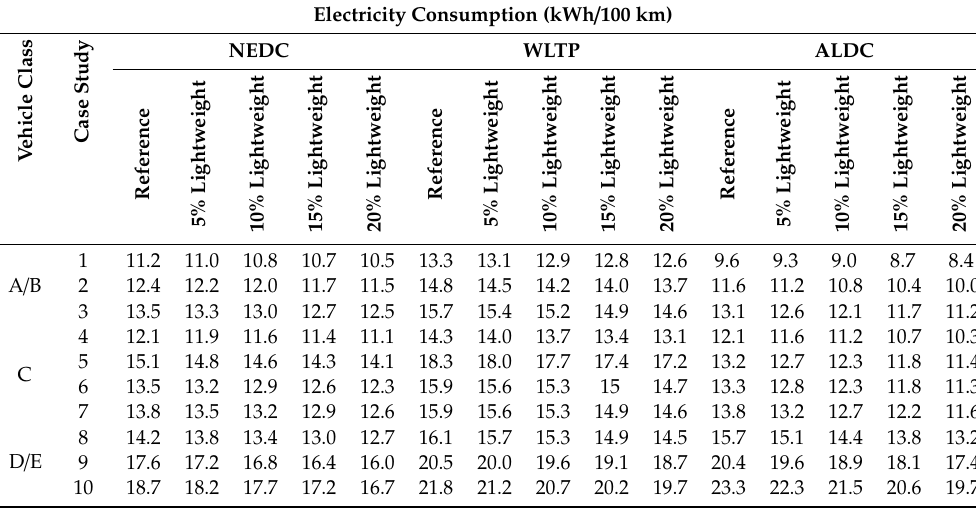
Figure A2. Energy consumption in function of mass with regression lines and ERV coefficient. Table A3. Electricity consumption of vehicle case